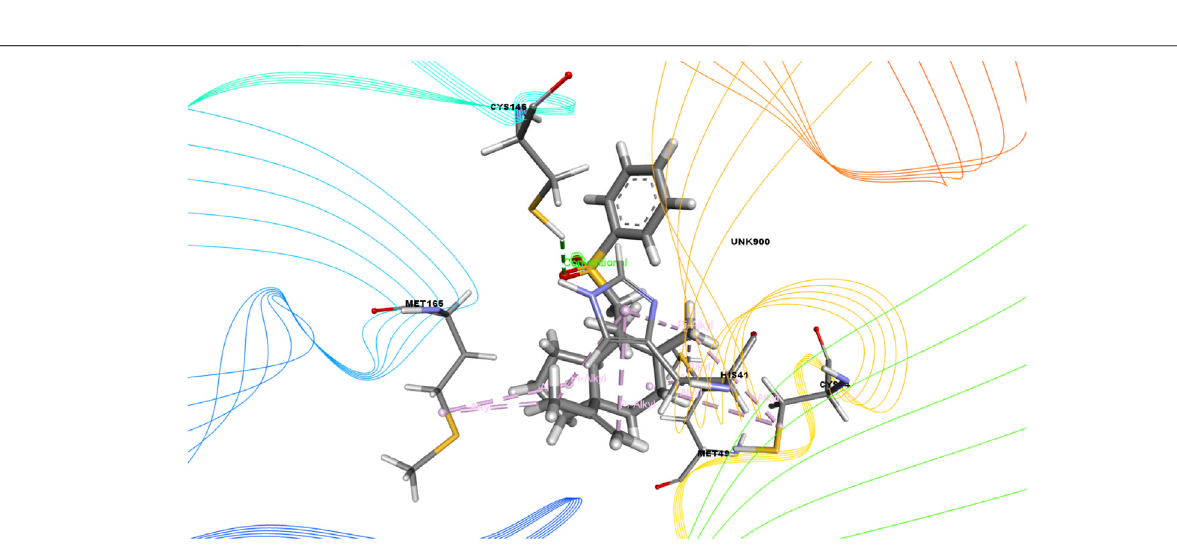
Frontiers in Molecular Biosciences |